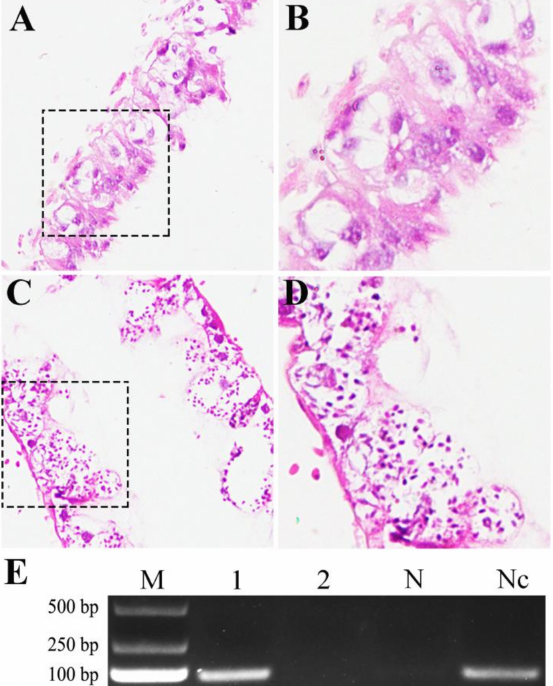
Figure 1. Confirmation of effective infection of A. c. cerana worker by N. ceranae . ( A , B ) Microscopic observation of paraffin section of workers’ midgut at 12 dpi without N. ceranae under 200 times ( A ) and 400 times ( B ) amplification. ( C , D ) Microscopic observation of paraffin section of workers’ midgut at 12 dpi with N. ceranae under 200 times ( C ) and 400 times ( D ) amplification. Black dashed boxes show the selected regions for microscopic observation under 400 times amplification. ( E ) AGE for PCR amplification products from N. ceranae -inoculated workers’ midgut and un-inoculated workers’ midgut. Lane M: DNA marker; Lane 1: A. c. cerana workers’ midgut at 12 dpi with N. ceranae ; Lane 2: A. c. cerana workers’ midgut at 12 dpi without N. ceranae ; Lane N: sterile water (negative control); Lane Nc: clean spores of N. ceranae (positive control).